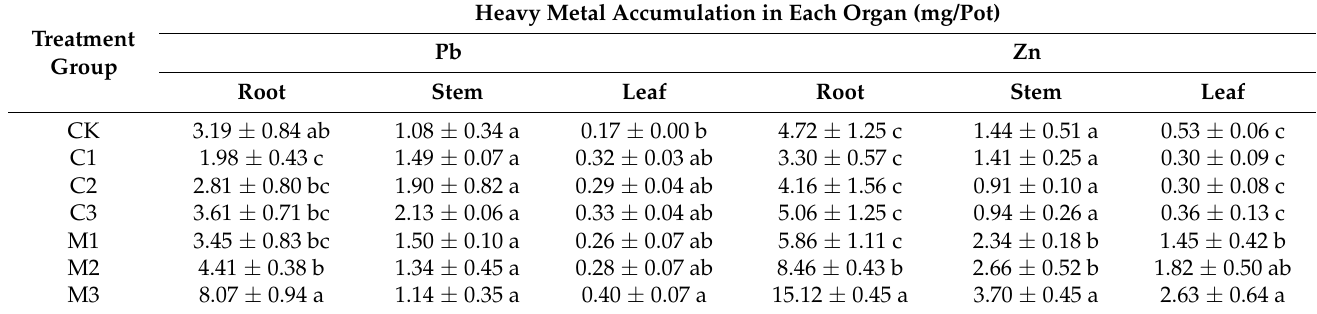
Table 5. Heavy metal accumulation in different organs of Nerium indicum